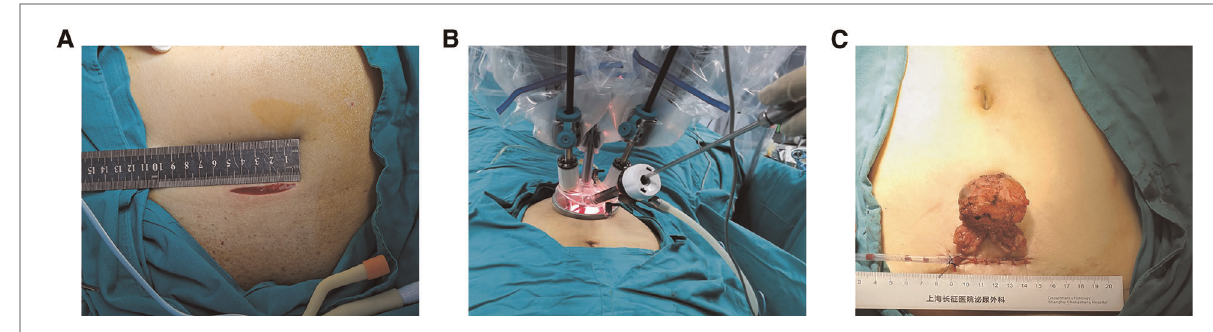
FIGURE 1 Illustration of extraperitoneal pure sp-RARP. ( A ) A 4 – 5 cm transverse abdominal incision approximately 5 cm above the pubic symphysis. ( B ) Intraoperative installation showing a scope holder arm and the two primary robotic arms. ( C ) Wound closure with drainage placed in the single- port incision. sp-RARP, single-port robotic-assisted radical prostatectomy.